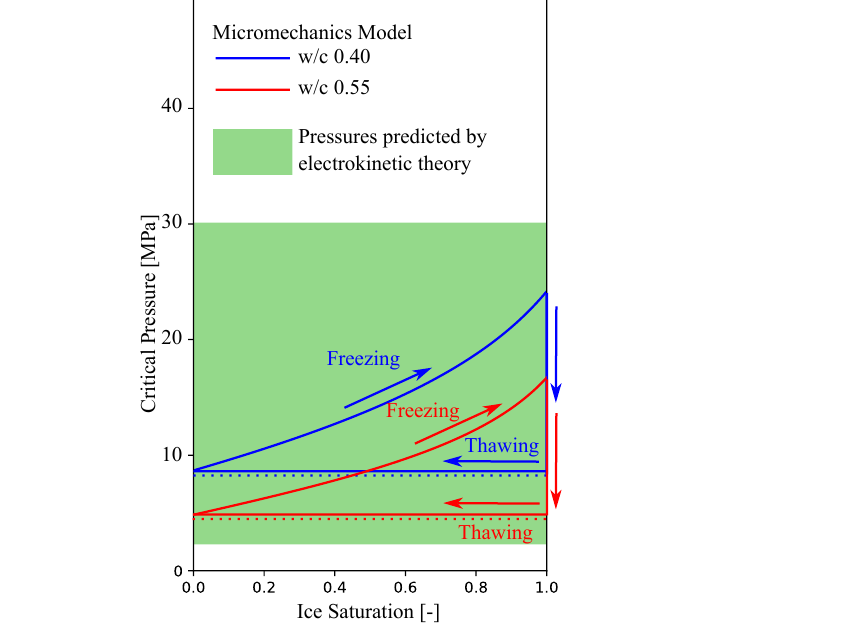
Figure 4. Pressure in the microcracks required for initiation of microcrack growth (damage) according to the theoretical predictions of the micromechanics model for two different mortar compositions. The dotted horizontal lines denote the tensile strength of the unsaturated (i.e., empty microcracks) mortar specimens. The green region shows the range of pressures predicted by the multiscale electrokinetic theory